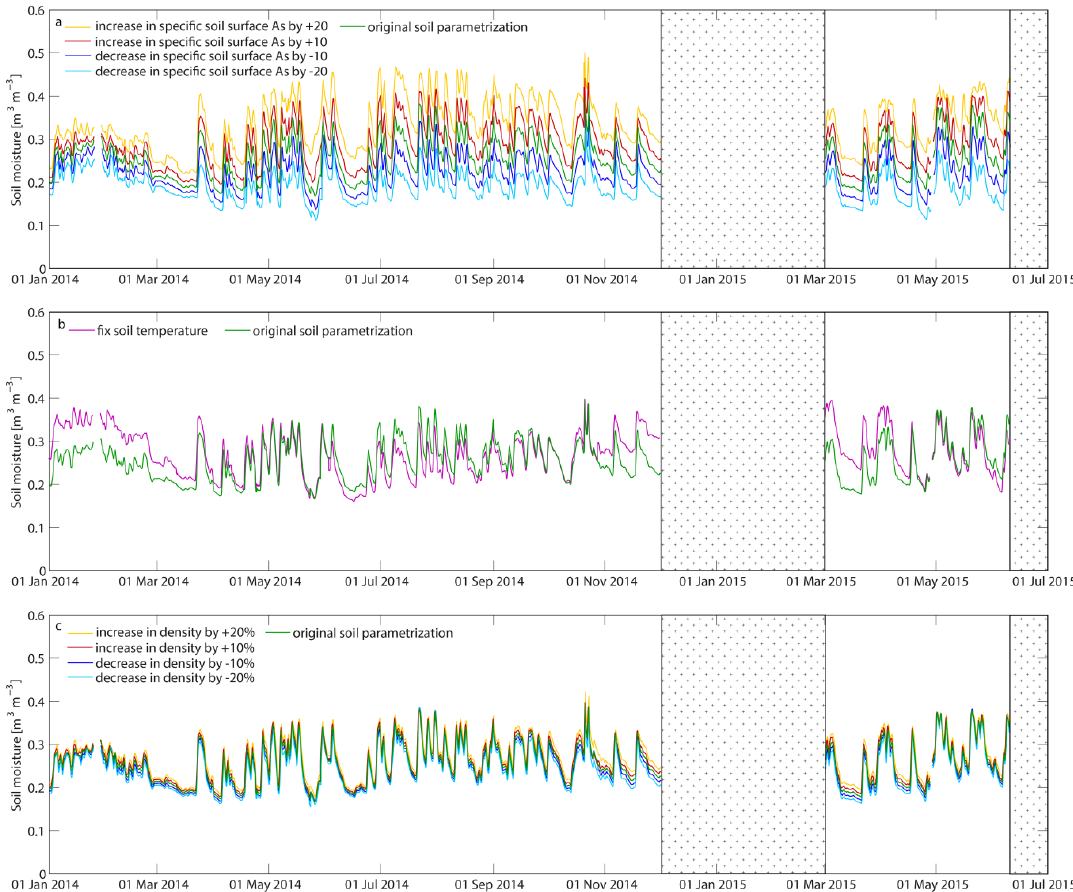
Figure 7. Soil moisture derived from GPS containing different assumptions on ( a ) an increase or decrease of the specific soil surface (cid:1827) (cid:3046) , which is an indicator for different soil texture assumptions of ±10 and ±20 ; ( b ) a fixed soil temperature assumption of 15 °C and ( c ) a soil density over- and underestimation of ±10% and ±20% compared to the original parameterized calculations at the DWD test site in Munich during the measurement period 1 January 2014–10 June 2015.